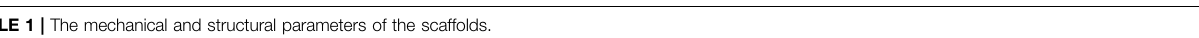
TABLE 1 | The mechanical and structural parameters of the scaffolds.